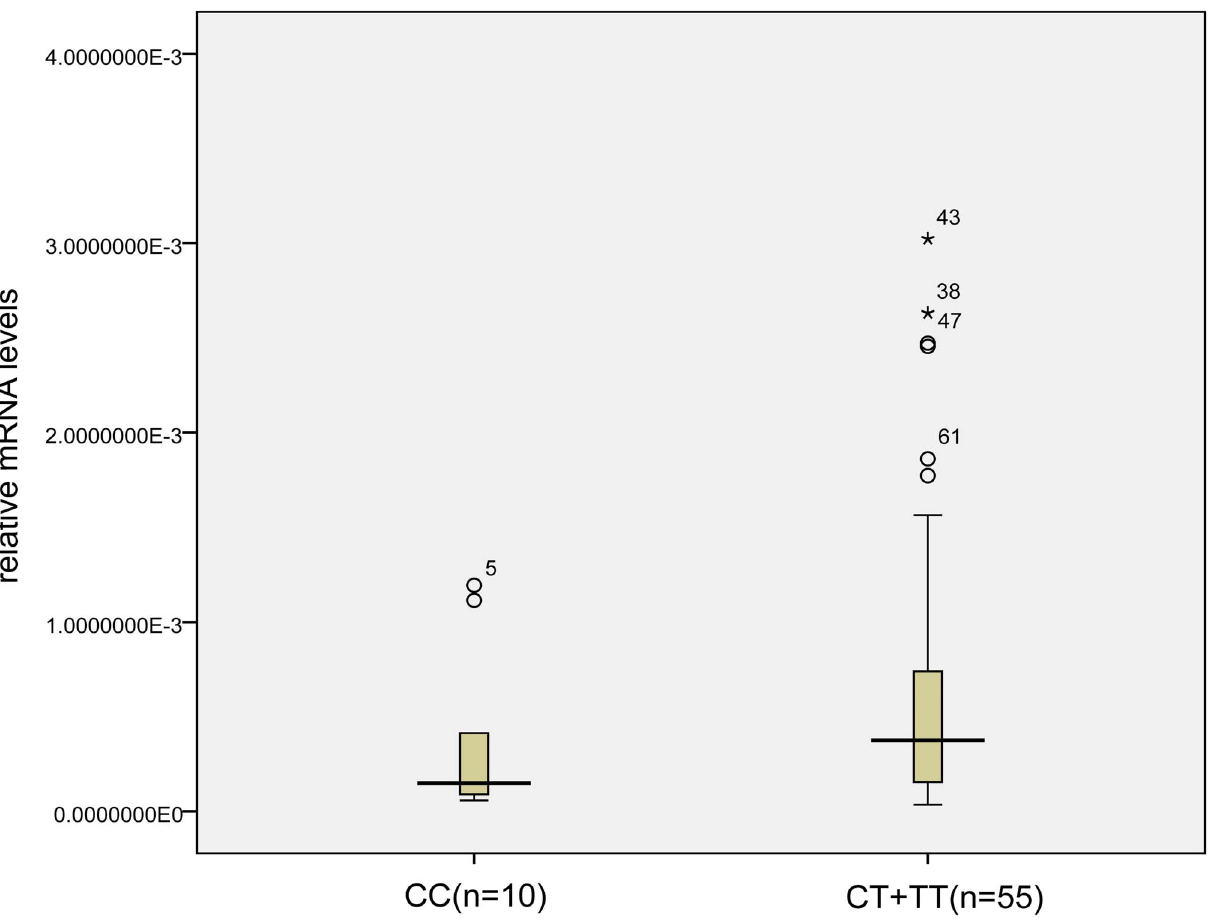
Figure 1. The comparison of MLXIP mRNA expression levels between carriers with CC genotype and CT + TT genotype. The SNP rs4758685 located in the 3 9 UTR of MLXIP and the mRNA expression level is tend to be lower in the CC genotype carriers than in the CT + TT genotype carriers.